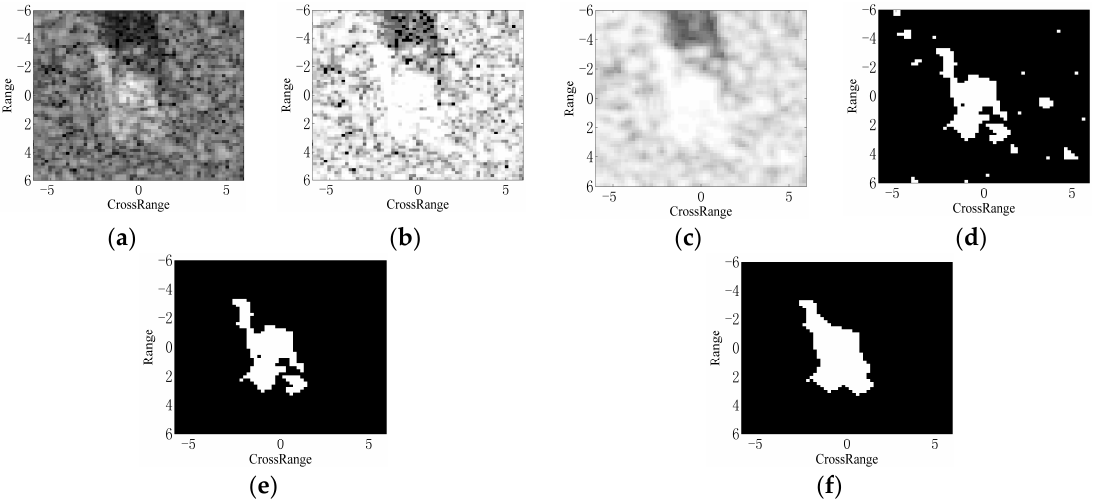
Figure 1. Illustration of the target segmentation algorithm: ( a ) original SAR image of BMP2 tank; ( b ) equalized image; ( c ) smoothed image after mean filtering; ( d ) preliminary segmentation result; ( e ) result after the opening operation; ( f ) result after the closing operation.